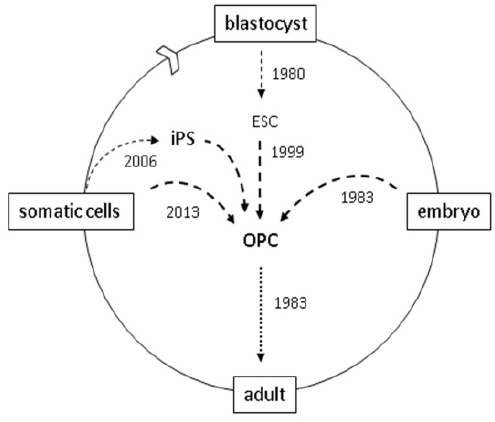
Figure 1. oligodendrocyte progenitor cell (OPC) resources for brain and spinal cord grafts. 1983: OPCs were first characterized in rodents [7]; OPCs were first grafted into shiverer mice [5]; 1999: OPCs generated by in vitro differentiation of mouse blastocyst-derived embryonic stem cells (ESCs) [16]; 2005: OPCs used to repair spinal cord injured rats [17]. 2006: human OPCs generated from induced pluripotent stem (iPS) cells [18]; 2010: human ES-derived OPCs first used in clinical trials; 2013: murine OPCs generated by direct cell reprogramming